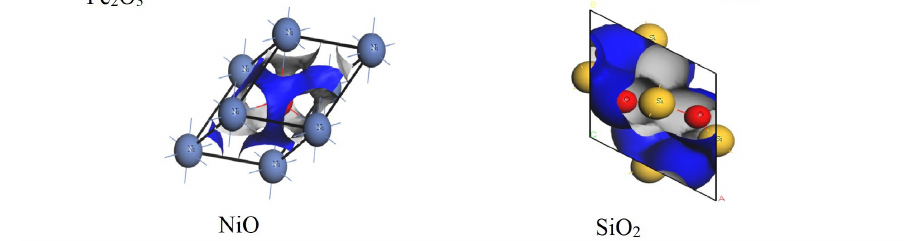
Figure 2. Charge density plots of metal oxides(unit cell).